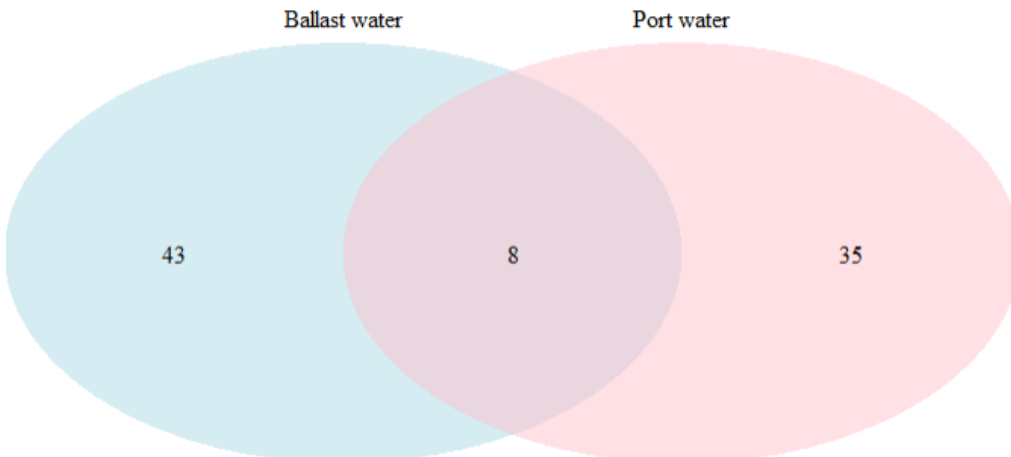
Figure 3. Venn diagram showing the number of unique species present in BW and port water and overlapped species between them.